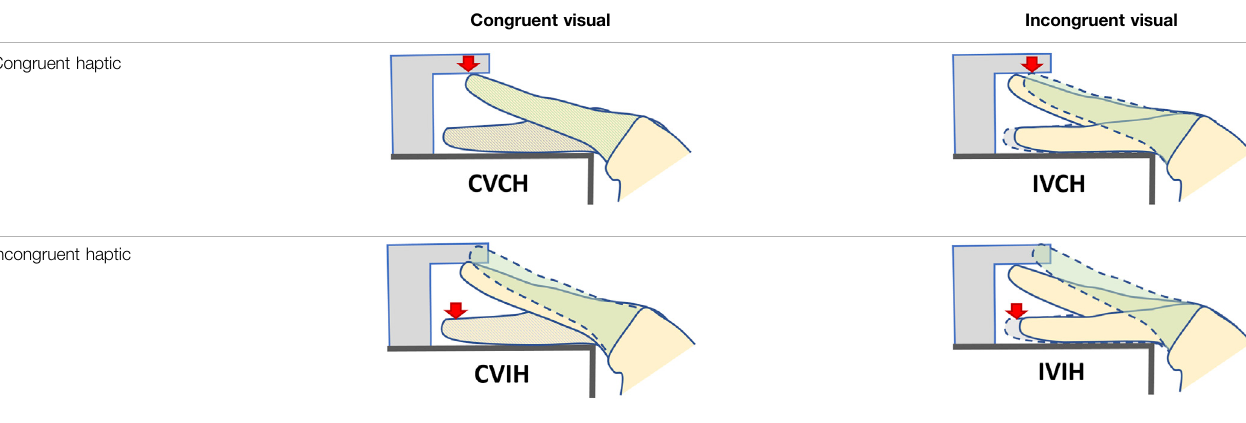
TABLE 1 | Experimental conditions illustrated in the context of the subject moving their index fi nger (highlighted in green with plain line if displayed or dotted line otherwise).